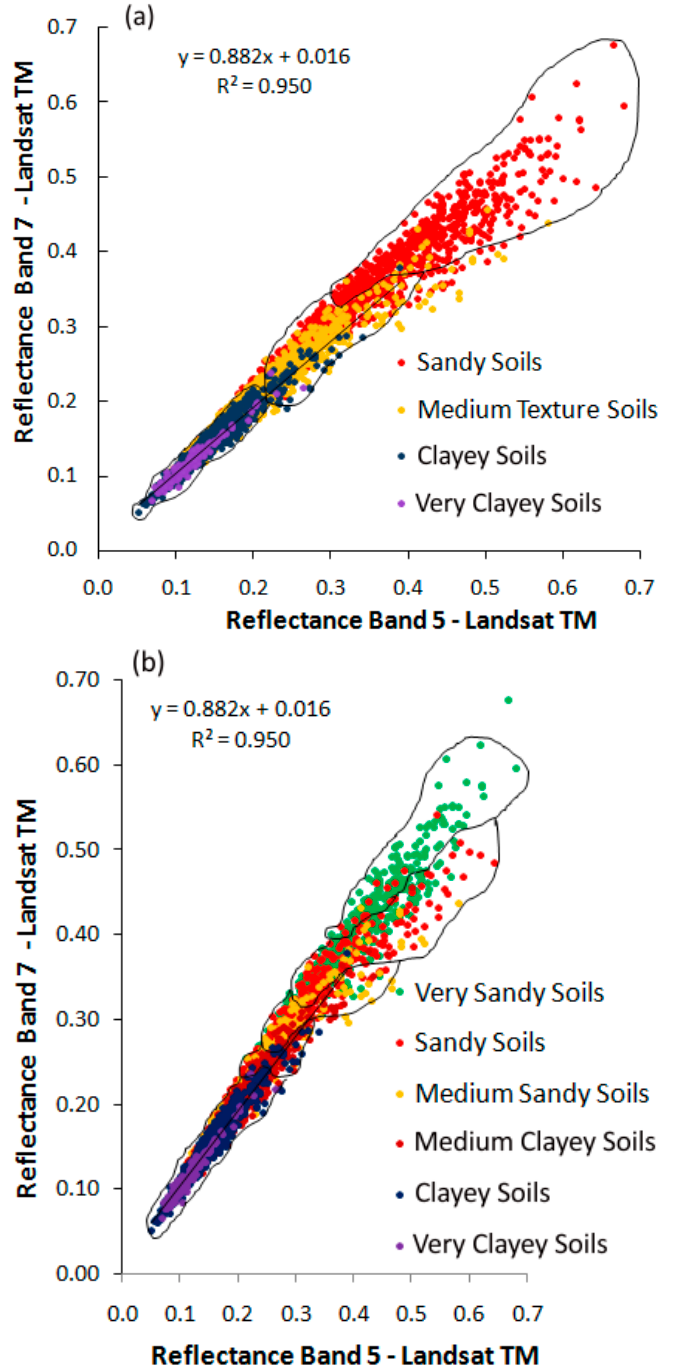
Figure 5. Soil lines obtained for the soils studied through laboratory data simulating the TM5 and TM7 bands: ( a ) distribution of textural classes according to the grouping for simplified classification according to SiBCS and ( b ) distribution of textural classes according to the LBTC.